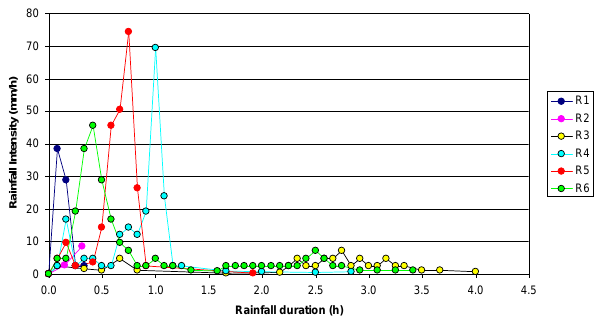
Figure 3 : Precipitation intensity (mm/h) for the different collected events. Fig. 3. Precipitation intensity (mm/h) for the different collected